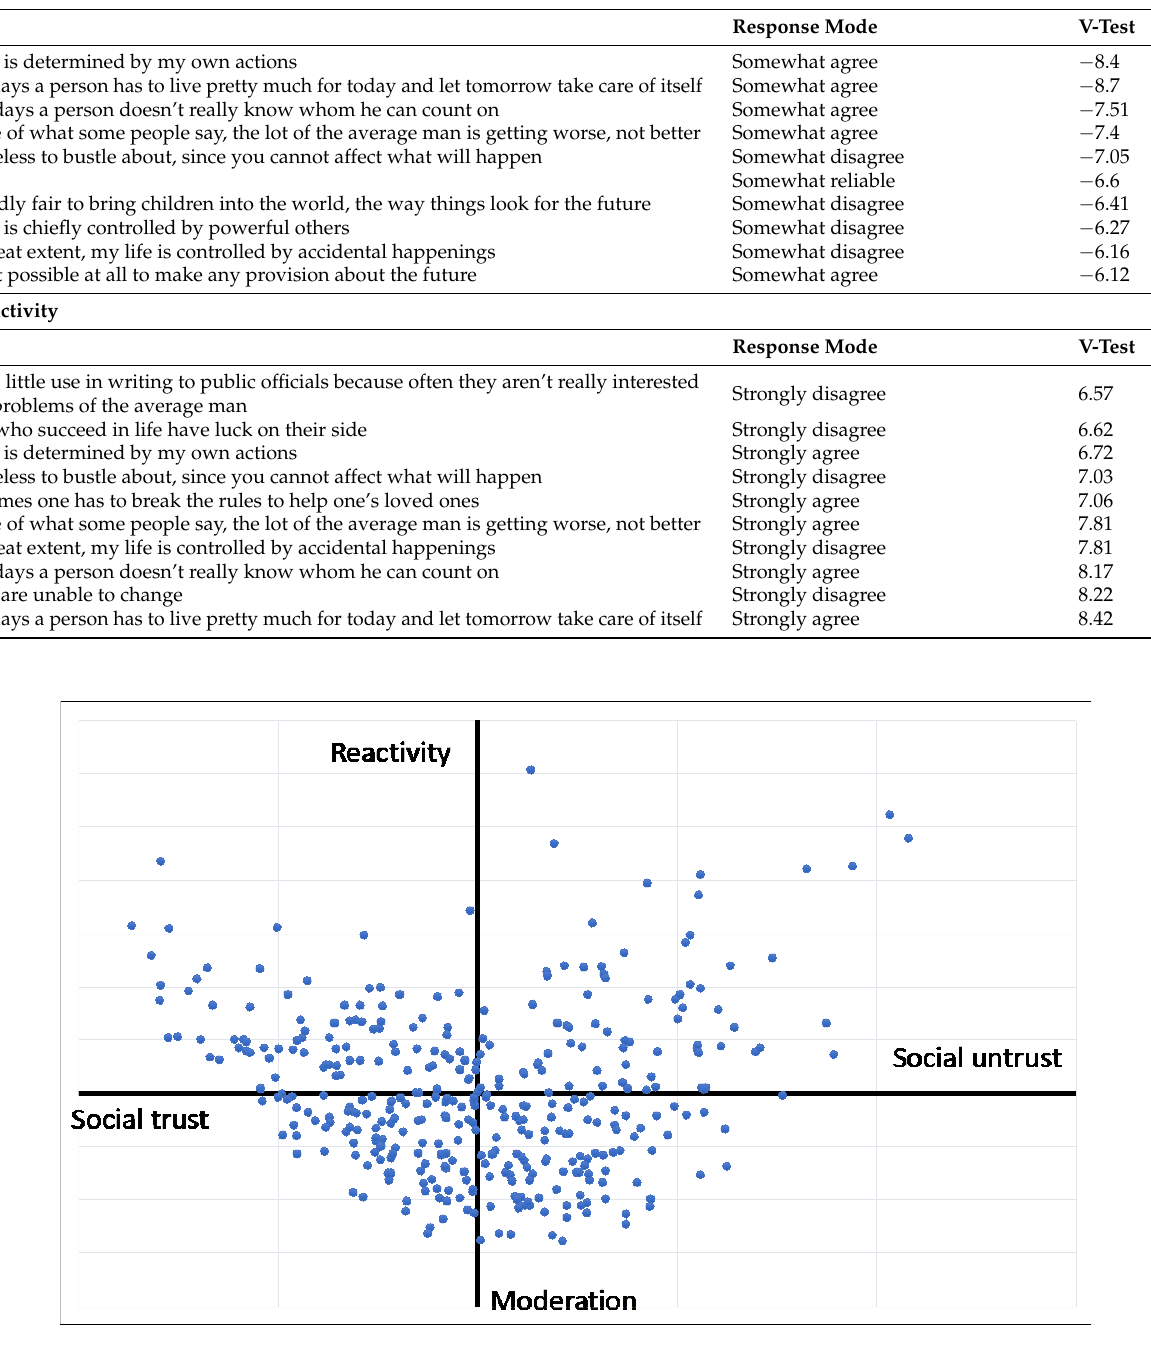
Figure 1. Individual positioning on the retrieved factors space.